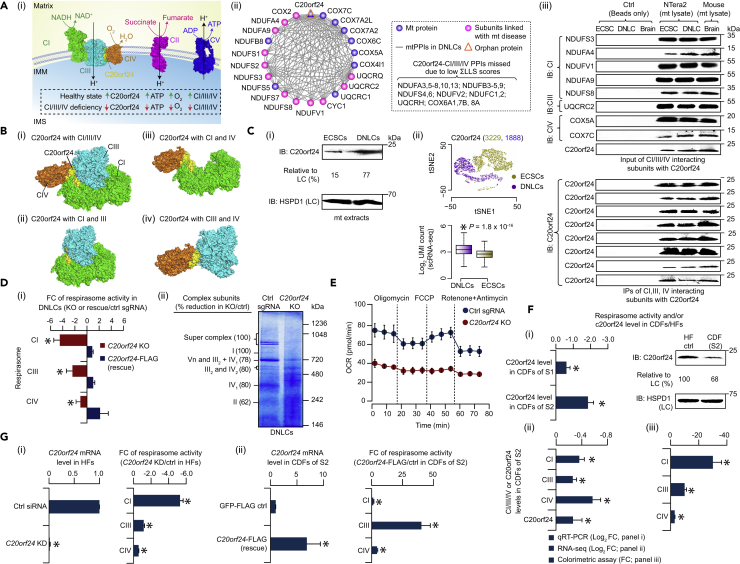
C20orf24 is Required for Respirasome Assembly(A) Model of C20orf24-respirasome interplay in healthy individuals versus patients with respiratory chain defects (i). Sub-network of C20orf24 link with CI/III/IV subunits in DNLCs (gray lines; ii). CI/III/IV-specific antibody immunoprecipitates and input from the mt extracts of ECSCs, DNLCs, and mouse brain immunoblotted (IB; iii) with antibody raised against C20orf24 and its interacting proteins; protein G beads alone (without antibody) served as negative control.(B) Docking of C20orf24 (yellow) on the human respirasome CI (green), CIII (cyan), and CIV (orange) structures (i) is shown as a zoom-in where C20orf24 can be seen at the interface with indicated structures of respiratory complex subunits (ii–iv).(C) Endogenous C20orf24 level in ECSCs and DNLCs with anti-C20orf24 (i). Band intensities normalized to HSPD1 loading control (LC). t-SNE (t-distributed stochastic neighbor embedding) plot (ii; number of single cells shown in parentheses) and log2 UMI (unique molecular identifier) counts (ii; *p value by Wilcoxon rank-sum test) of the C20orf24 transcript in DNLCs over ECSCs.(D) Respirasome activity (fold change, FC) of C20orf24 KO or complemented with FLAG-tagged C20orf24 (rescue) versus control (ctrl) single-guide RNA (sgRNA) in DNLCs (i). Respirasome complexes in control and C20orf24 KO DNLCs by BN-PAGE (ii); percent reduction of respirasome complex subunits in KO over control is shown after subtracting background signals from each band.(E) Oxygen consumption rate (OCR) measured in control and KO DNLCs under basal conditions followed by the sequential addition of oligomycin (1 μM), FCCP (0.25 μM; carbonyl cyanide-p-trifluoromethoxyphenylhydrazone), as well as rotenone and antimycin A (0.5 μM).(F) C20orf24 mRNA or respirasome activity measured by qRT-PCR (i; FC, fold change), RNA sequencing (ii), or colorimetric assay (iii) in the CIV-deficient fibroblasts (CDFs) of two subjects (S1, S2) versus healthy fibroblasts (HFs). Immunoblotting (i) of endogenous C20orf24 level in HFs or CDFs (S2) with anti-C20orf24. Band intensities normalized to HSPD1 loading control (LC).(G) C20orf24 mRNA or respirasome activity measured by qRT-PCR or colorimetric assay in C20orf24 knockdown (KD) versus control (ctrl) of HFs (i) or CDFs of S2 complemented with C20orf24-FLAG (rescue) versus GFP-FLAG control (ii). Data for (D, E, F, and G) are mean ± SD (n = 3 technical replicates; *p ≤ 0.05 by Student's t test).See also Figure S5 and Table S1.